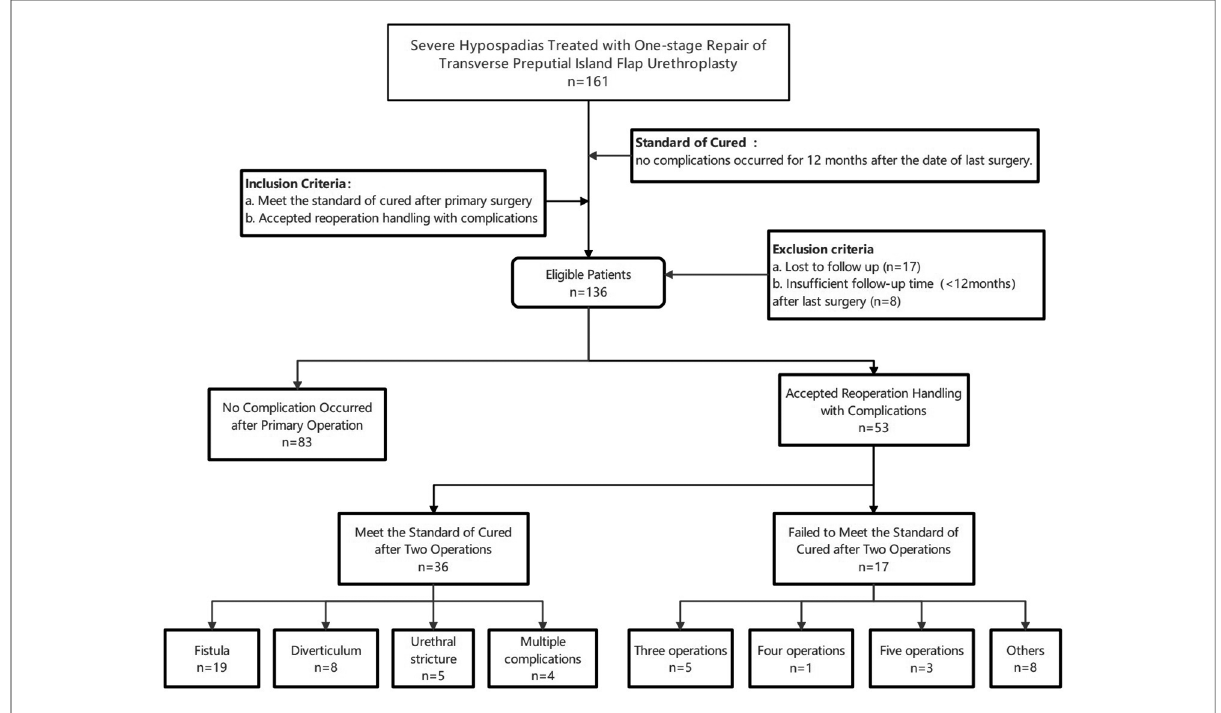
FIGURE 2 Reoperation analysis of TPIFU treating severe hypospadias. TPIFU, transverse preputial island fl ap